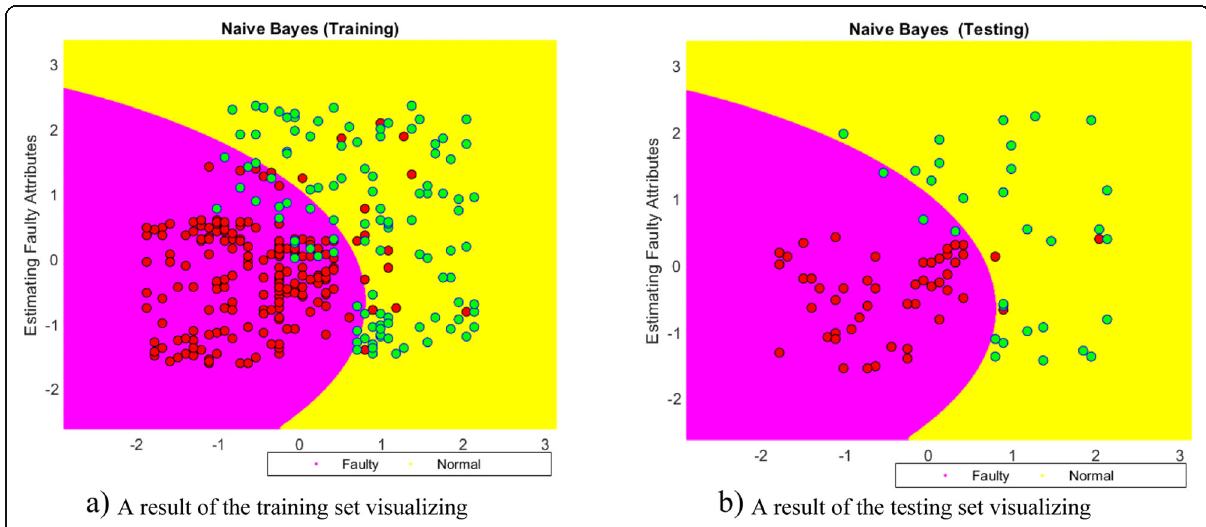
Fig. 7 A visualization of the training and testing set